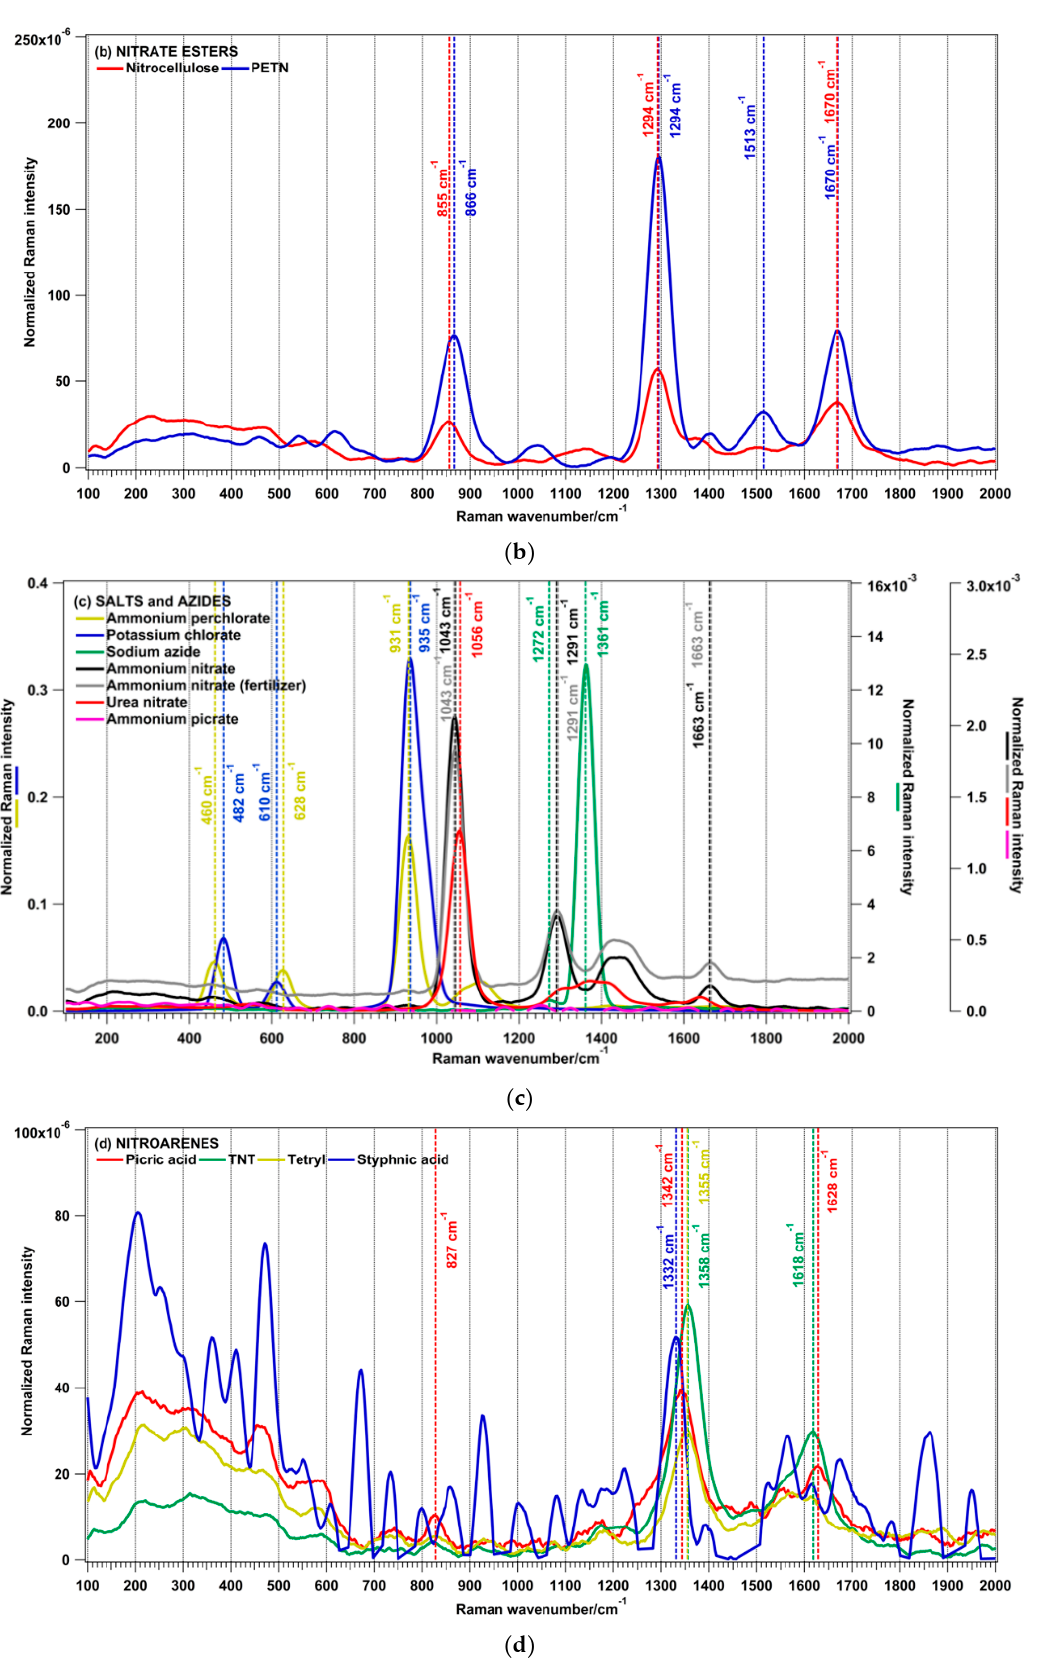
Figure 6 . Cont. Figure 6. Cont